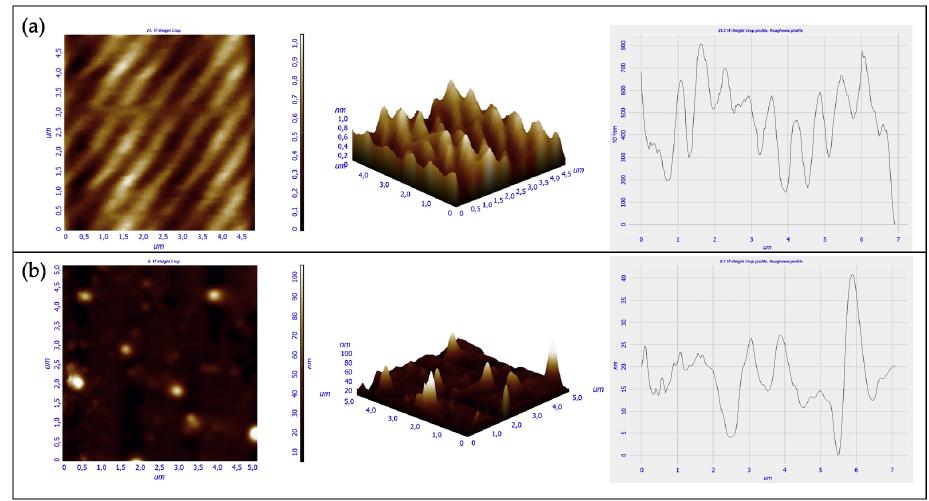
Figure 12. Measurements conducted from the top view in both VeroClear RGD 810 ( a ) and NOA88 ( b ).